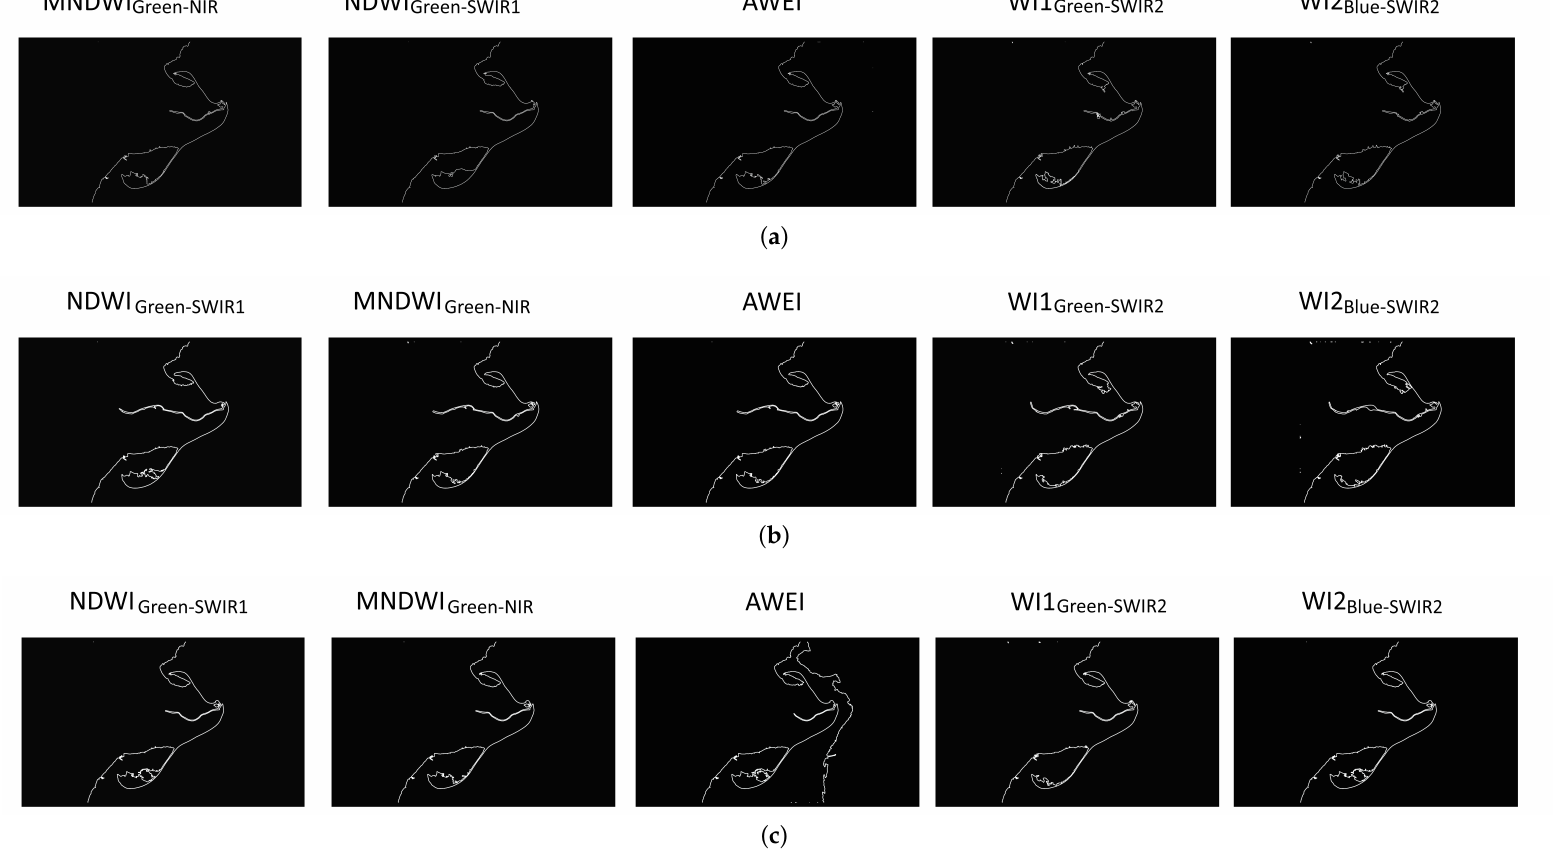
Figure 12. Shorelines extracted from TM, ETM+, and OLI images in the Ebro River Delta. ( a ) The shoreline detected on a TM image on 11 October 2011. ( b ) The shoreline detected on an ETM+ image recorded on 22 January 2000. ( c ) The shoreline detected on an OLI image recorded on 3 October